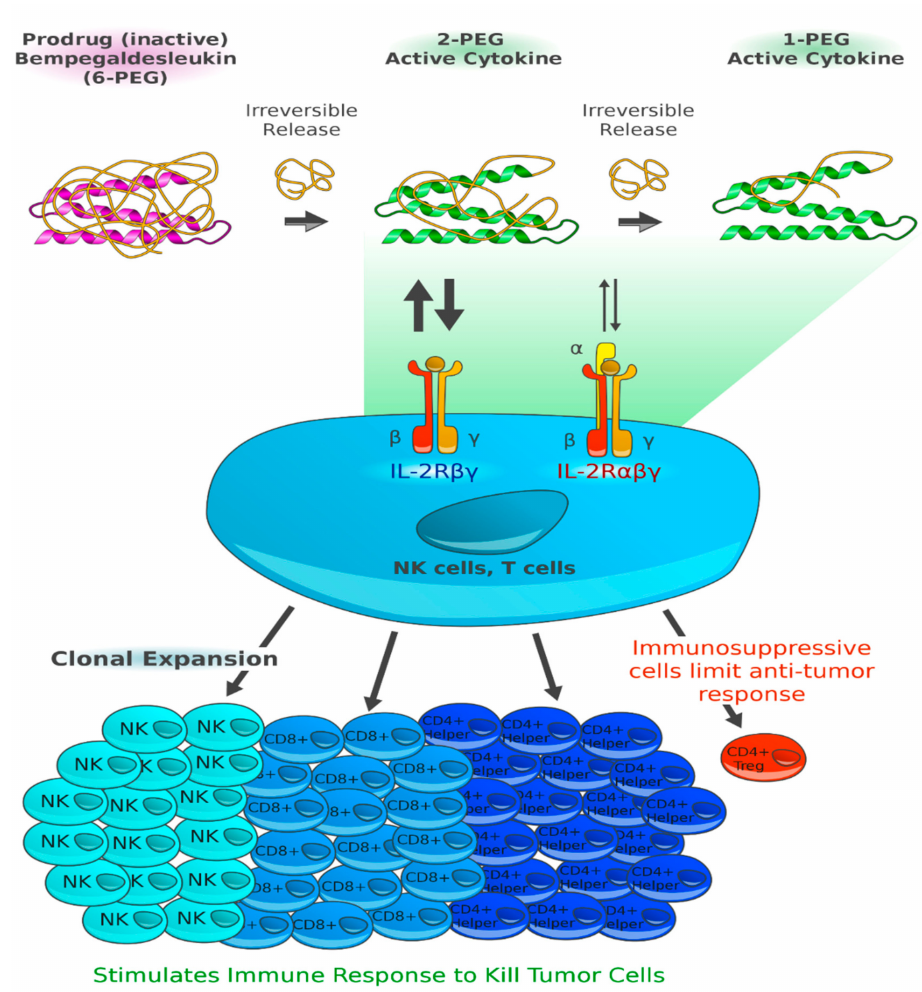
Figure 2. Bempegaldesleukin expands and activates cluster of di ff erentiation (CD)8 + e ff ector T cells and natural killer cells over regulatory T cells. Bempegaldesleukin (BEMPEG; NKTR-214) is a human recombinant inteleukin-2 (IL-2) attached to six releasable polyethylene glycol (PEG) chains that alter its pharmacokinetics and its receptor binding. When fully PEGylated, NKTR-214 is a prodrug with no biological activity. In vivo, the PEG chains slowly release to generate active IL-2 conjugates with limited binding to the IL-2R α subunit, thereby favoring the dimeric βγ -IL-2 receptor (IL-2R βγ ; CD122). Consequently, NKTR-214 is selectively stimulating CD8 + T cells and natural killer (NK) cells over the undesirable T regulatory cells (Treg) [25]. (Reference: Figure adapted from Charych D [26] and created by F.F.